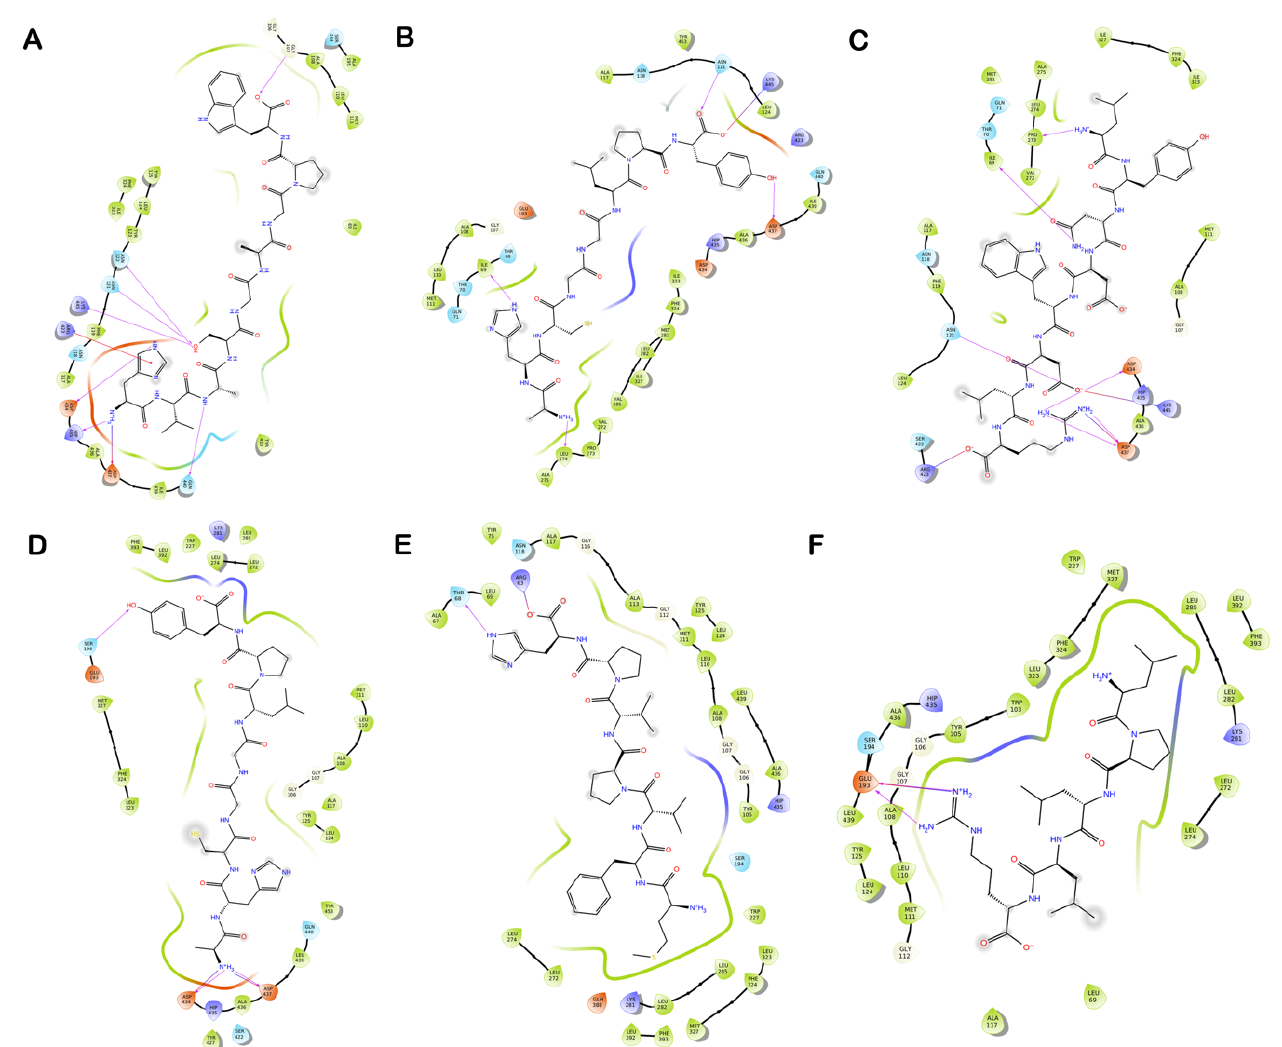
Figure 2. Ligand interaction diagram of inhibitory peptides with the residues of the enzyme CEase. The interactions of peptides ( A ) HVASGAGPW, ( B ) AHCGGLPY, and ( C ) LYNDWDLR in the active site human CEase. Interactions of peptides ( D ) AHCGGLPY, ( E ) MFVPVPH and ( F ) LPLLR in the active site of bovine CEase. Purple circles represent positively charged amino acids, red circles represent negatively charged amino acids, green circles represent hydrophobic amino acids, and light blue circles represent polar amino acids. Purple dashed arrows represent hydrogen bonds involving amino acid side chain and regular purple arrows represent hydrogen bonds involving the amino acid backbone. π - π interactions are represented with green lines.